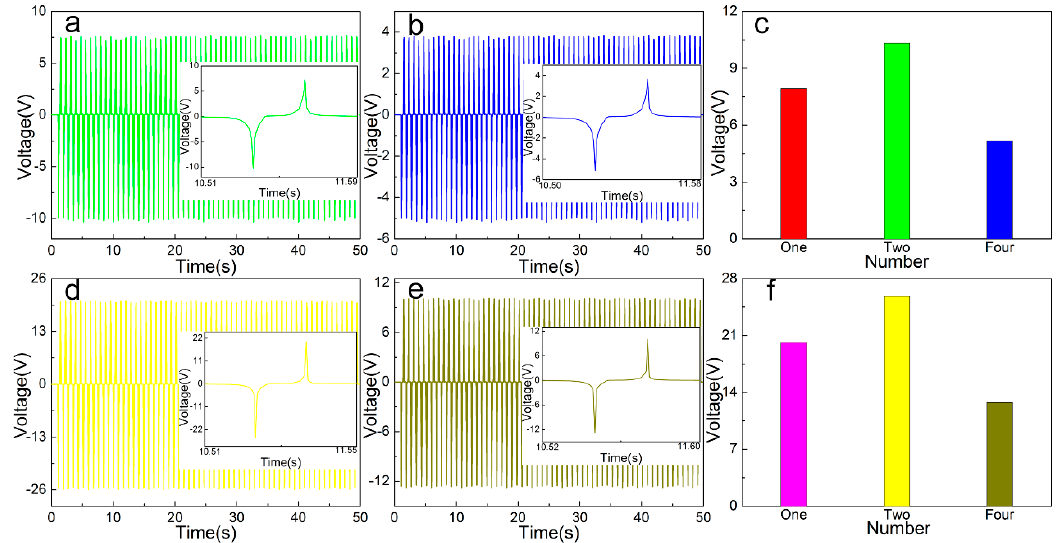
Figure 7. Output voltage of different number of TENG: ( a )Cel, ( b )Cel + PA6, ( c )Cel + PA6 + BaTiO 3 , ( d ) Cel + PVDF, ( e ) Cel + PVDF + BaTiO 3 , ( f ) maximum instantaneous value.